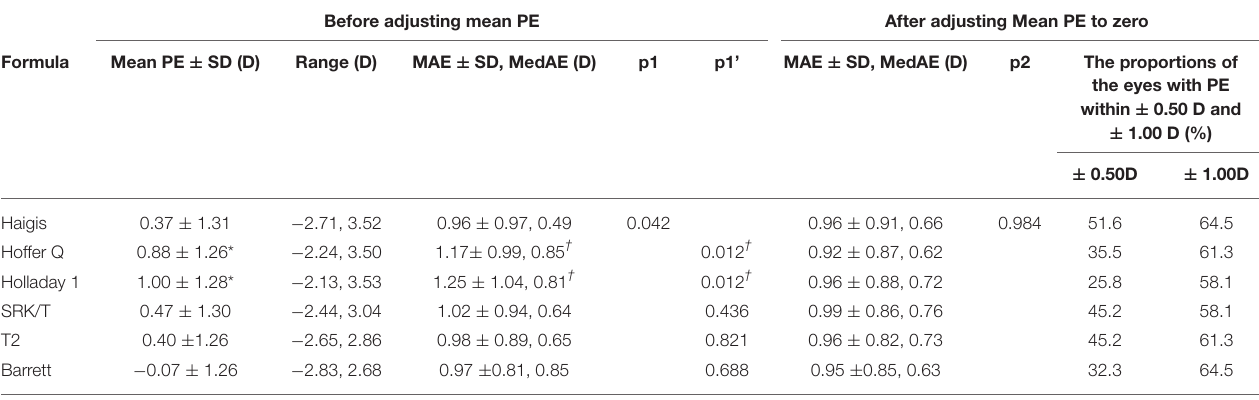
TABLE 5 | Postoperative refractive results of Group B (31.00 ≥ AL > 29.00). Before adjusting mean PE After adjusting Mean PE to zero